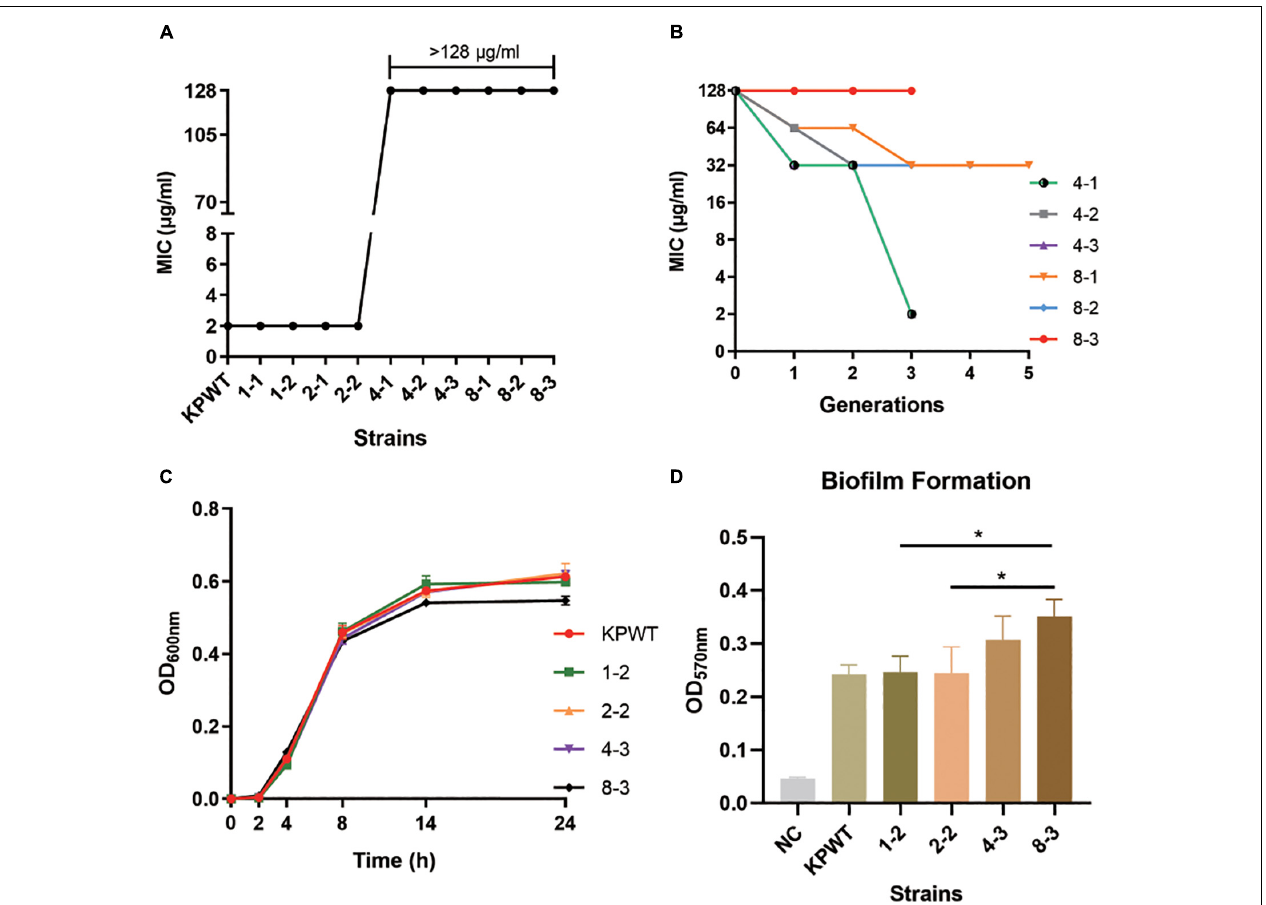
FIGURE 1 | Resistance to polymyxin B (PB) and growth characteristics of Klebsiella pneumoniae parent isolate and induced strains. (A) PB MIC against K. pneumoniae strains before and after induction. (B) Changes in PB MICs of induced strains passaged in antibiotic-free medium. (C) Growth curve of parent isolate and induced strains. (D) Comparison of biofilm formation ability. The data shows the mean ± SD of three independent replicates. * P < 0.05. NC, negative control. The induced strains were named in a PB concentration-passage manner, e.g., 1-2, the second generation of strain grown in the medium with PB concentration of 1 µ